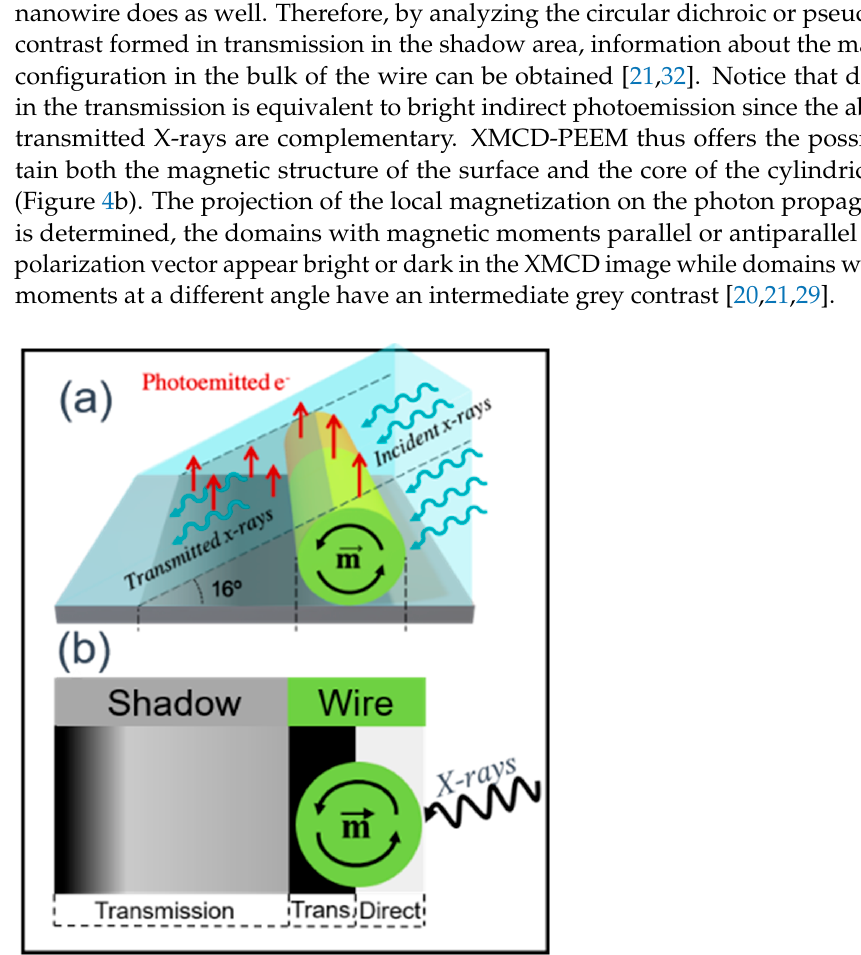
Figure 4. Schematic illustrations of ( a ) the principle of the dual sensitivity of Photoemission Electron Microscopy (PEEM) to detect direct photoemission and transmission data using X-ray Magnetic Circular Dichroism (XMCD) as a contrast mechanism, ( b ) magnetic contrast observed for direct photoemission and transmission. Adapted with permission from ref. [21]. Copyright 2016 Royal Society of Chemistry.